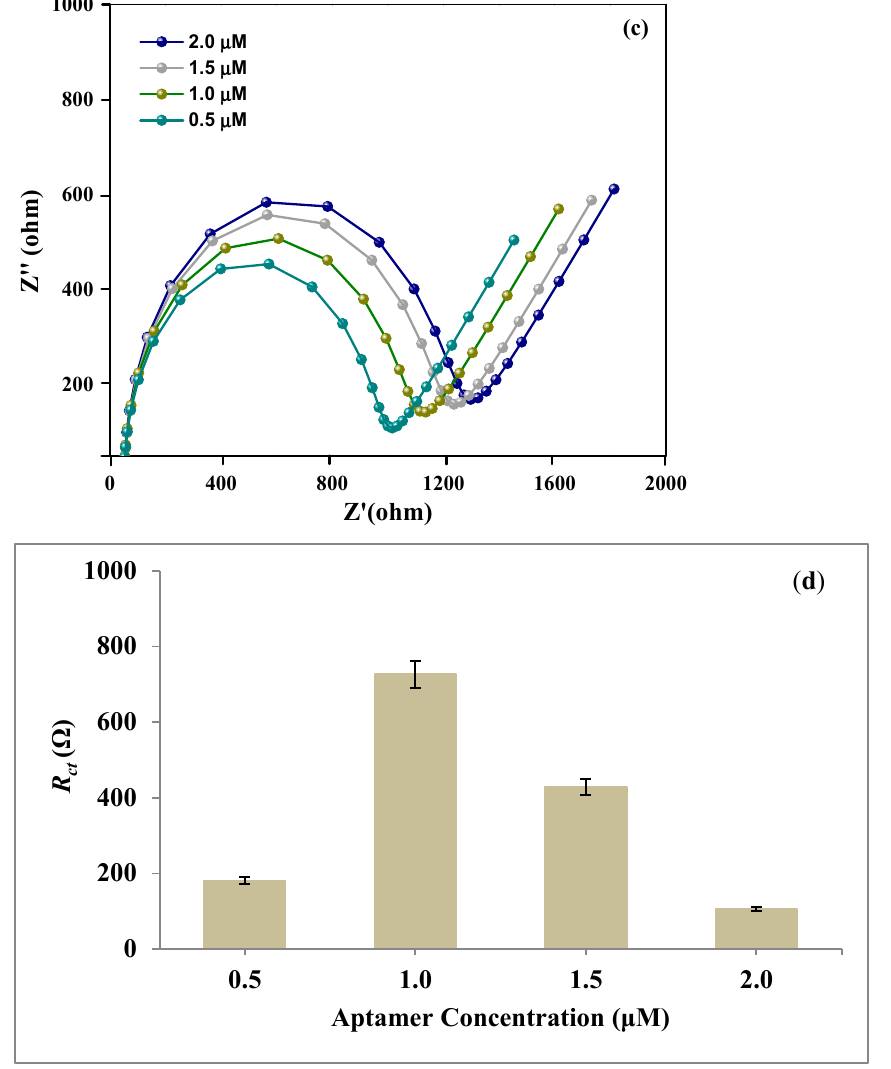
Figure 8. Optimization conditions to improve sensitivity of Apt MDMA /SnNPs@Au-modified elec- trode. ( a ) Bar graphs of Differential Pulse Voltammetry (DPV)-based peak currents at 5.0, 15, 30, and 45 min of SnNP electrodeposition. ( b ) Change in charge transfer resistance ( Δ R ct ) after incuba- tion of MDMA on Apt MDMA /SnNPs@Au electrode for 0, 15, 30, 45, 60, 75, 90, 105, and 120 min. ( c ) Impedance Spectroscopy (EIS) Nyquist plots at different Apt MDMA concentrations (0.5, 1.0, 1.5, and 2.0 μ M) in 5.0 mM [Fe(CN) 6 ] 3 − /4 − and 0.1 M KCl electrolyte. ( d ) Change in charge transfer resistance ( ∆ R ct ) of 0.5, 1.0, 1.5, and 2.0 µ M Apt MDMA -modified electrode in presence of ( ±